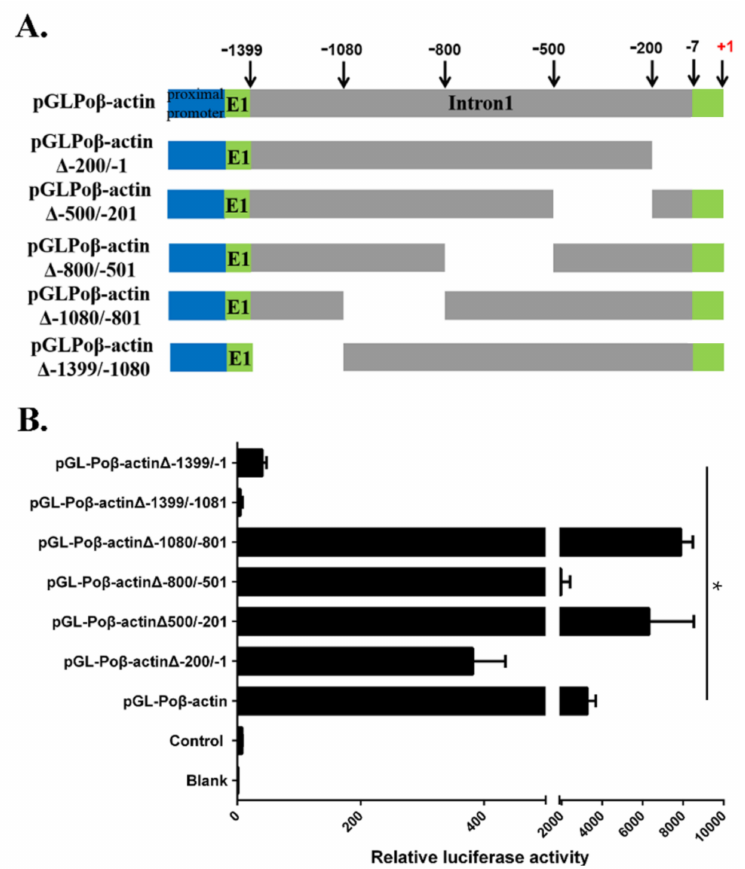
Figure 4. Characterization of regulatory region of 5 (cid:48) -flanking sequences of the flounder β -actin gene based on the reporter assay. ( A ): schematic diagram of series deletion constructs with the luciferase reporter gene, which were made as described in the Materials and Methods. ∆ indicates a deletion; and ( B ) the relative levels of reporter gene expression in FEC cells are shown. The constructs were transiently co-transfected into cells along with pRL-tk control vector. The activity of firely and Renilla luciferase in the cell lysate were measured using a dual-luciferase reporter assay (Promega) at 48 h post transfection. Firefly luciferase activity was normalized to Renilla luciferase activity. The bars indicated mean ± S.D. of luciferase activity ( n = 3). * indicates statistical significance ( p <